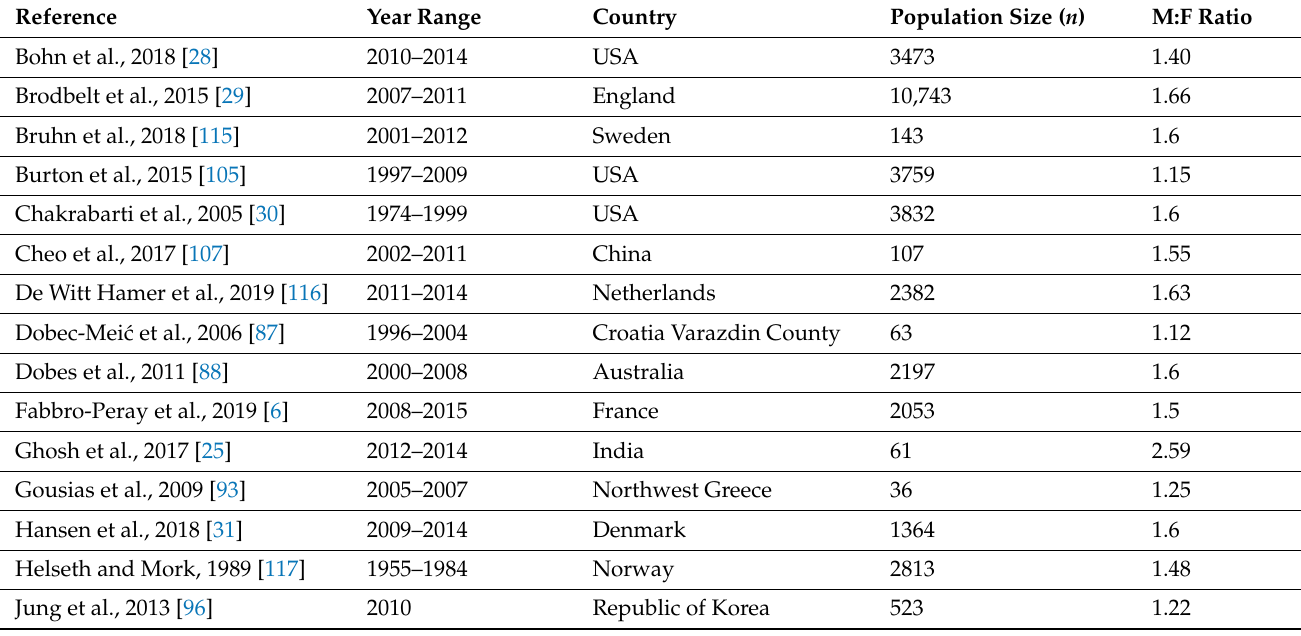
Table 3. Incidence rates of GBM presented for both